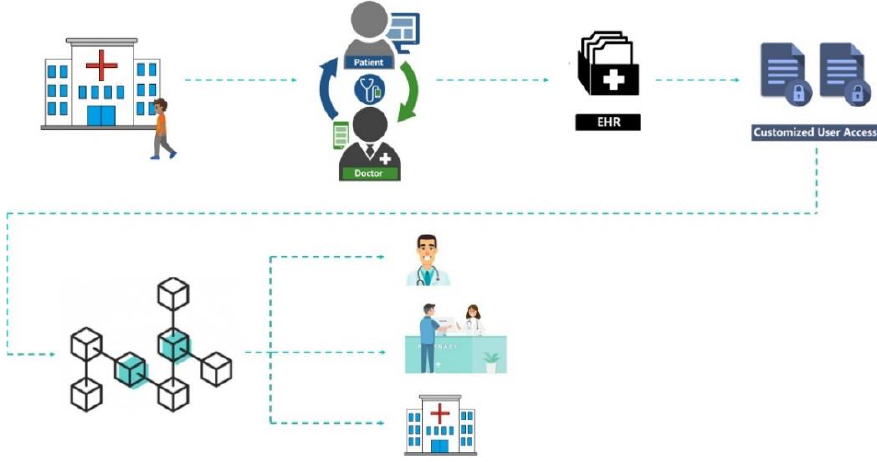
Figure 3. Information flow where patient data are stored on a private blockchain and patients allow access to their data.